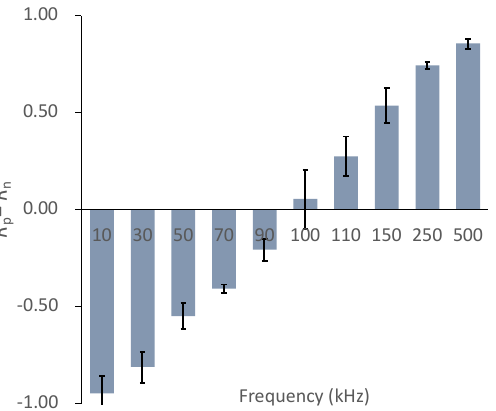
Figure 8. DEP frequency dependency parameter, R p − R n , of chondrocytes. Mean ± S.D., n = 5.